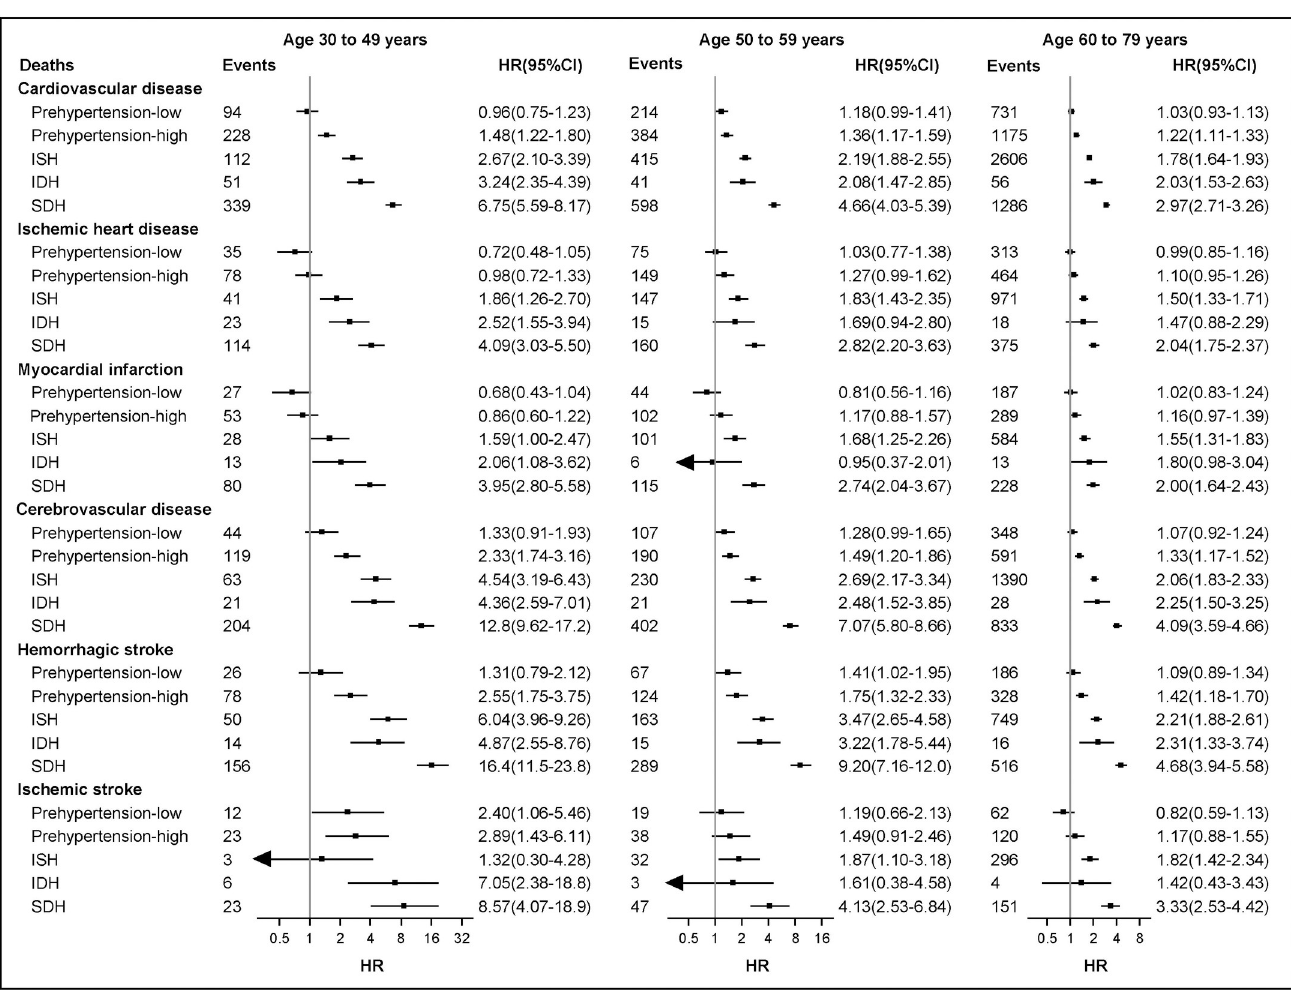
Fig 2. Associations of BP categories with mortality from CVDs and its major subtypes by age groups. Abbreviations: BP, blood pressure; CVDs, cardiovascular diseases; HR, hazard ratios; CI, confidence interval. Reference was normal BP. Multi-adjusted HR were adjusted for age, education level, marital status, smoking status, alcohol consumption, intake frequencies of vegetables, fruits, and red meat, physical activity, body mass index, survey season, heart rate, diabetes at baseline, family history of heart attack, stroke (only adjusted for in corresponding analysis of cause-specific mortality) and were stratified according to sex and survey sites. Statistically significant heterogeneity was observed in the associations between blood pressure categories and CVD mortality across age groups (all P values for interaction < 0.005, except for ischemic stroke P = 0.20). Data markers represent the point estimate of hazard ratio. Error bars represent 95% confidence interval. Black arrows represent the confidence intervals exceed the X-axis